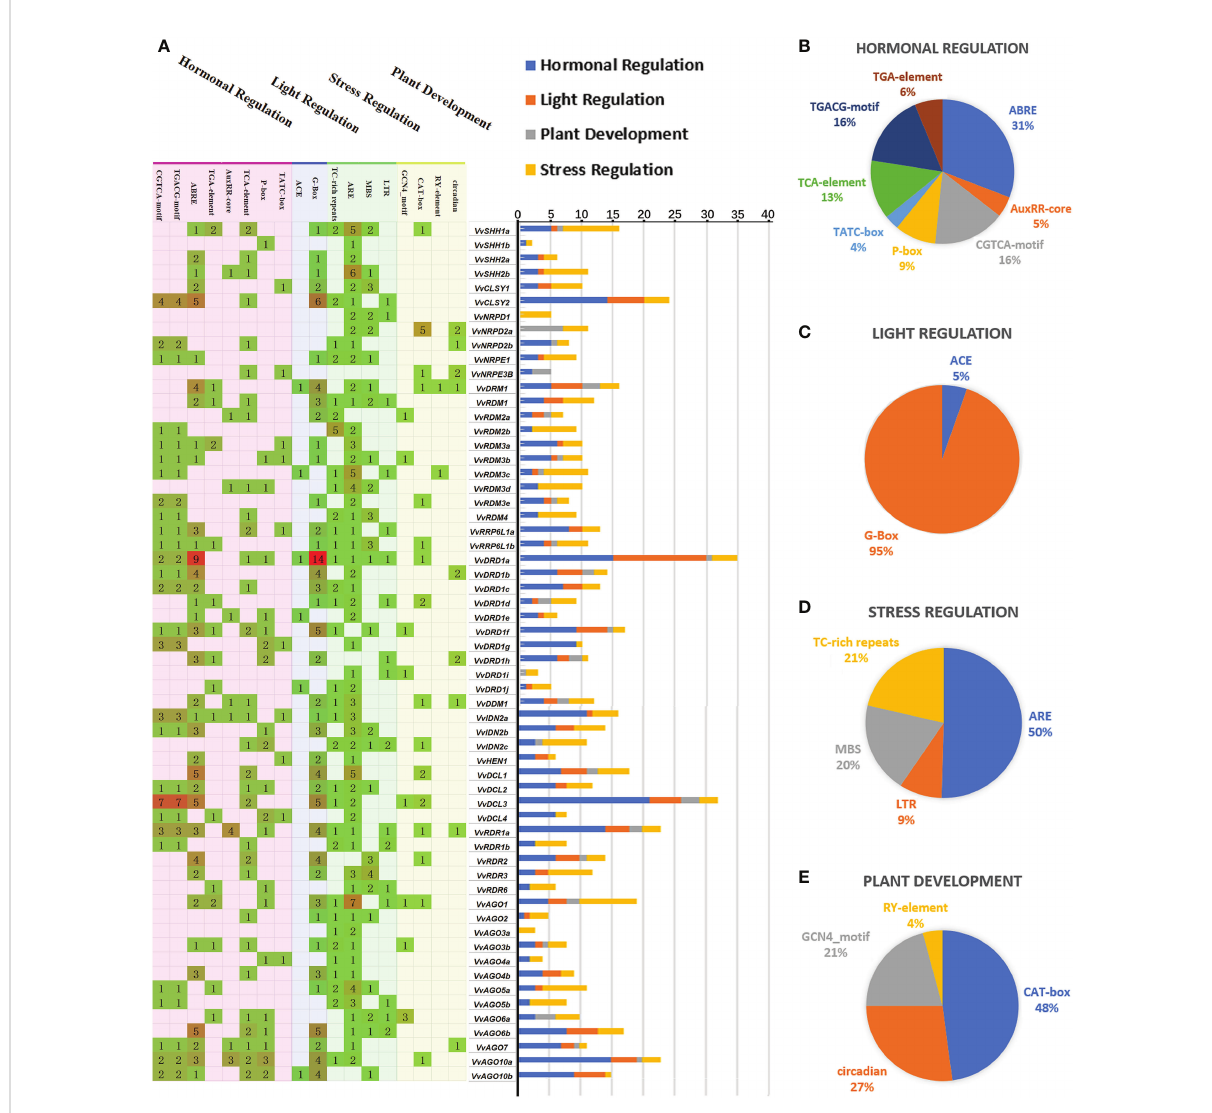
FIGURE 4 Cis-acting element analysis of VvRdDM genes. (A) The numbers and type of cis-elements in the VvRdDM promoter regions. The cis-elements belonging to different categorizes are denoted with different colors. (B) Relative percentage of hormonal regulation cis-elements. (C) Relative percentage of light regulating cis-elements. (D) Relative percentage of stress regulating cis-elements. (E) Relative percentage of plant development